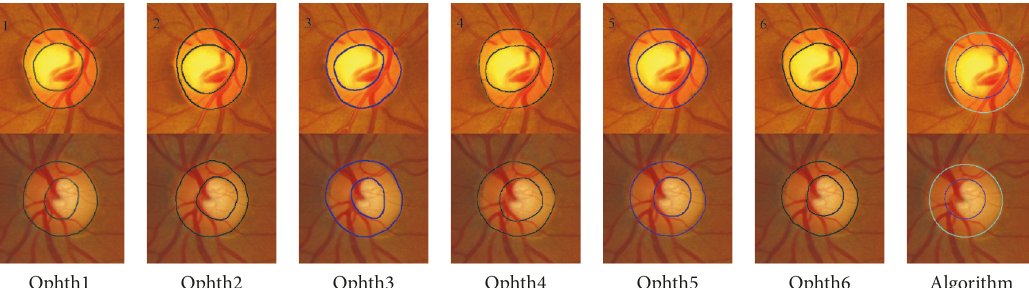
Figure 13: The algorithm final results for MESSIDOR images set.